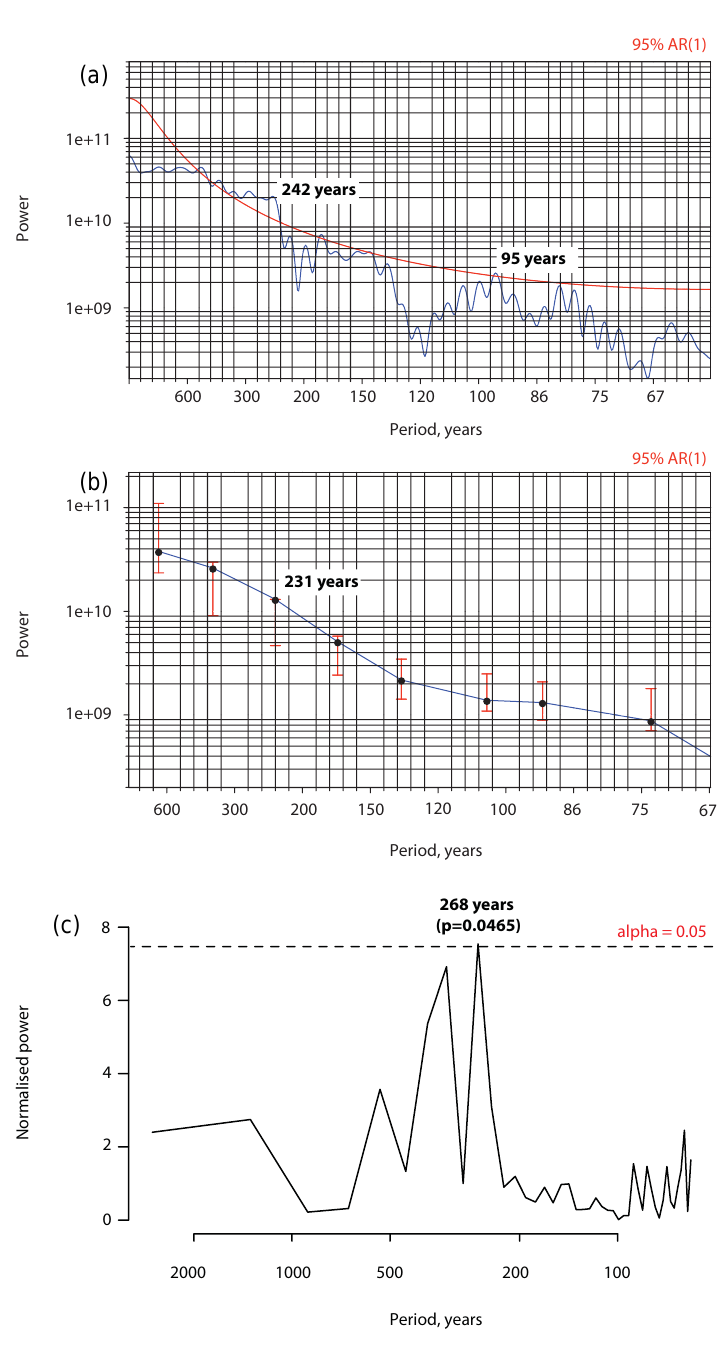
Figure 5. Multi-taper method (MTM) (a) , Monte Carlo single spectrum analysis (SSA) analyses (b) and Lomb–Scargle analysis (c) of charcoal from the Canopus Hill sequence. Error bars denote 95%